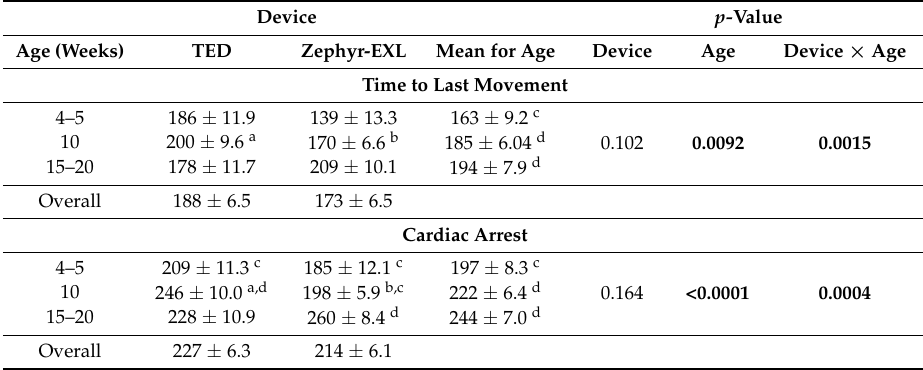
Table 6. Average end time of last movement and cardiac arrest for turkeys killed using either device (TED and Zephyr-EXL) across three age groups (4–5 weeks, 10 weeks, and 15–20 weeks), in addition to the mean value of the device by age interaction.